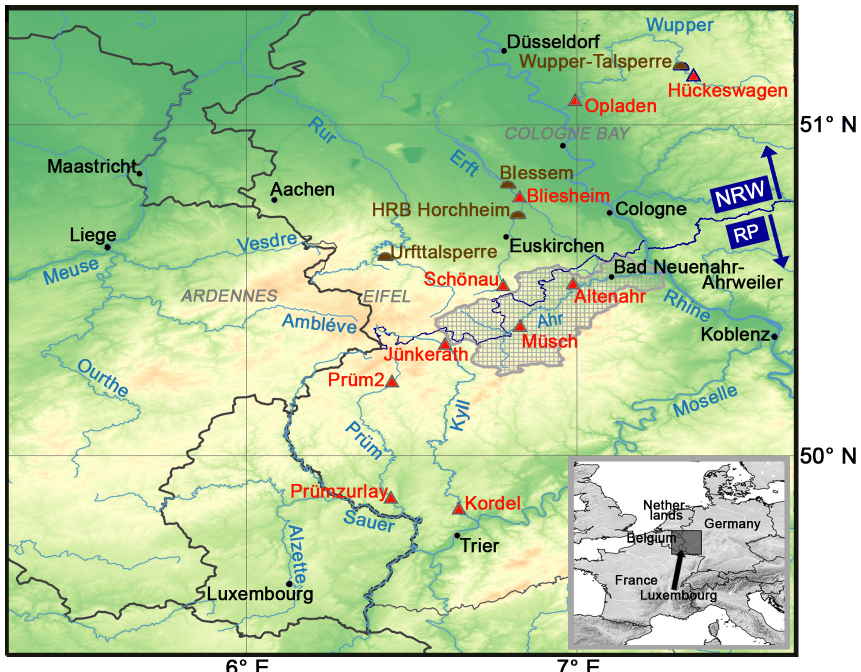
Figure 1. Overview map of the most affected region within the European context (inset at small bottom right), with the main rivers (blue), river gauges (red), and reservoirs (brown) addressed in the paper, including the catchments of the rivers Ahr and Erft (hatched gray). In addition, the low mountain range Eifel, the Ardennes (both part of the Rhenish Slate Mountains), the low terrace plain Cologne Bay (gray capital letters), and the border between the two federal states North Rhine-Westphalia (NRW) and Rhineland-Palatinate (RP) are labeled (dark